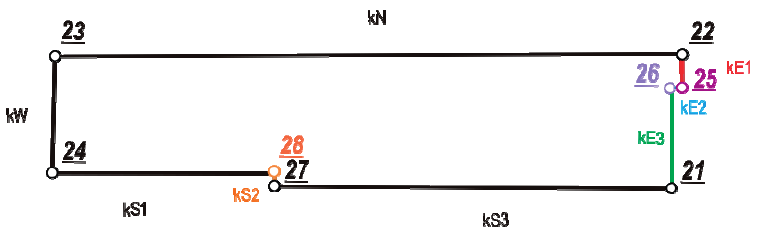
Figure 10. Sketch of test building with labeled vertices and